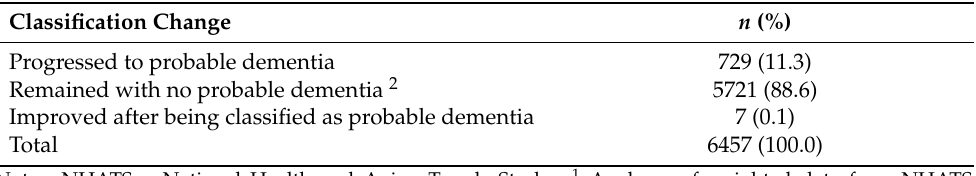
Table 2. Changes in dementia classification at the end of the observation period, NHATS, 2011–2018 1 .